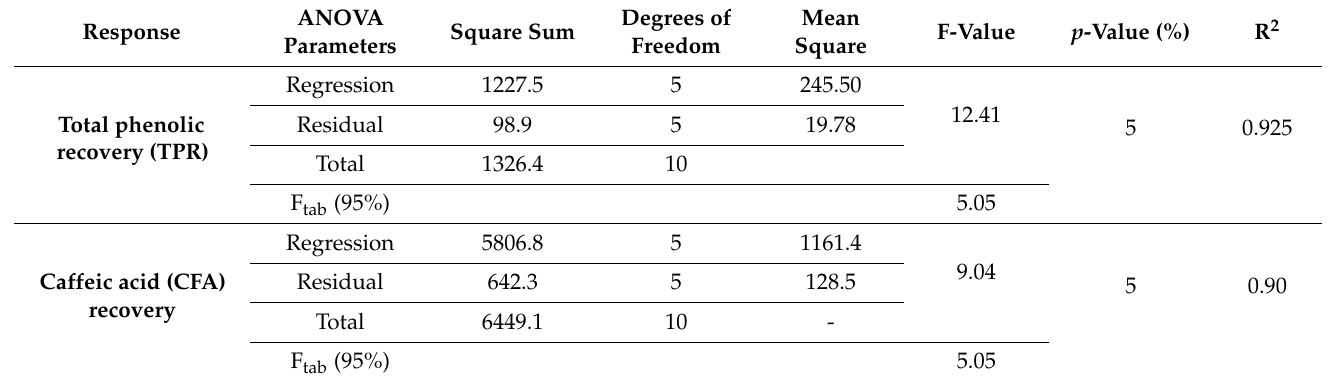
Table 5. Analysis of variance of the models generated for TPR and CFA recovery.